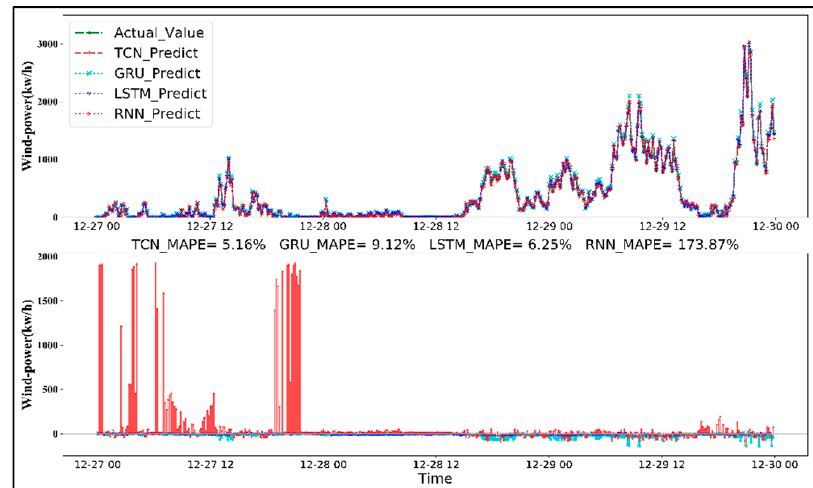
Figure 13. 48-h wind power forecasting (Experiment II).